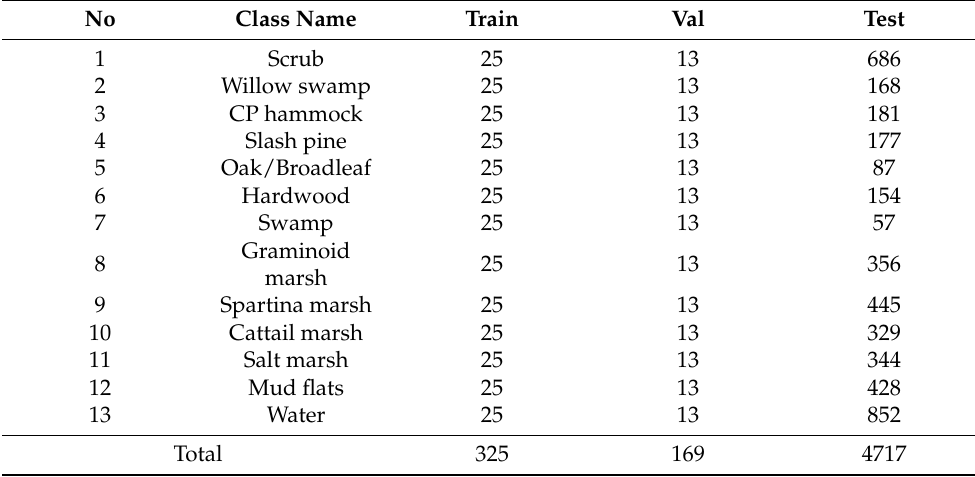
Table 5. The number of training, validation, and testing samples in the KSC data